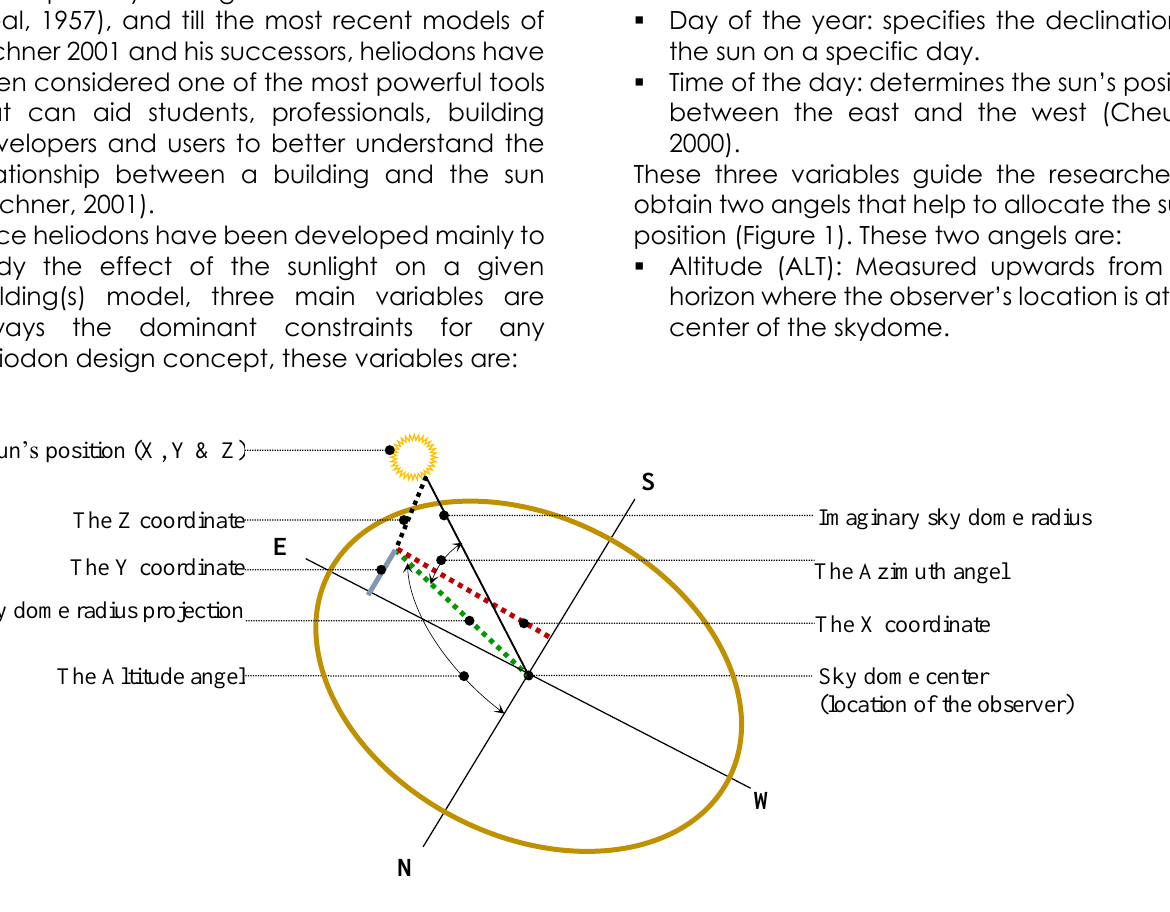
Figure 1. Converting the sun’s position parameters from the angels - Altitude & Azimuth - system to the coordinates - X, Y & Z – system.  Azimuth (AZI): measured in the horizontal plane from north or south (Szokolay,